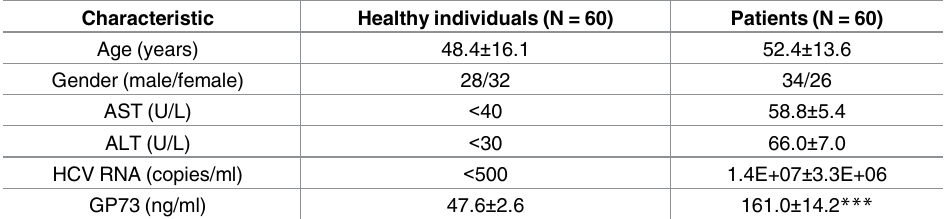
Table 1. Baseline characteristics of HCV-infected patients and healthy